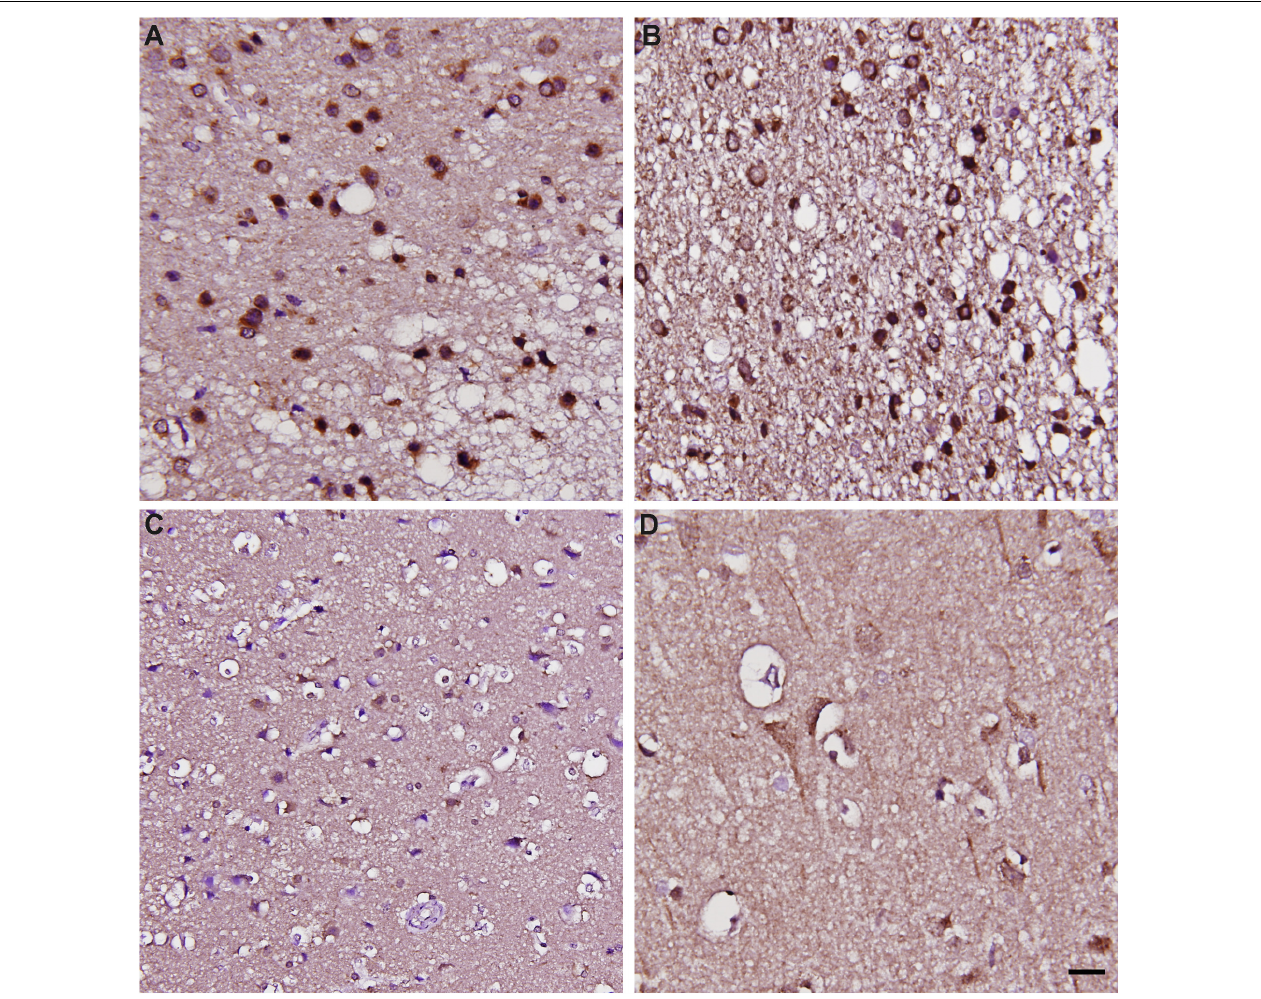
FIGURE 9 | Immunohistochemical staining of CARMIL3 in human infarct brains and stroke-free autopsied brains. (A–C) CARMIL3 expression in human infarct brain tissues. In the region most sever ely infarcted (right lower part of A ), there were fewer neurons, with all the residual neurons strongly positive for CARMIL3. In the area surrounding the sever ely infarcted region, most neurons had strong CARMIL3 staining in their nuclei and cytoplasm. In the region with the least infarction severity (left upper part of A ), most neurons had normal nuclear morphology with faint CARMIL3 staining mainly in the cytoplasm. (D) Relatively low CARMIL3 expression in the neurons of stroke-free autopsied brains. Scale bar = 20 µ